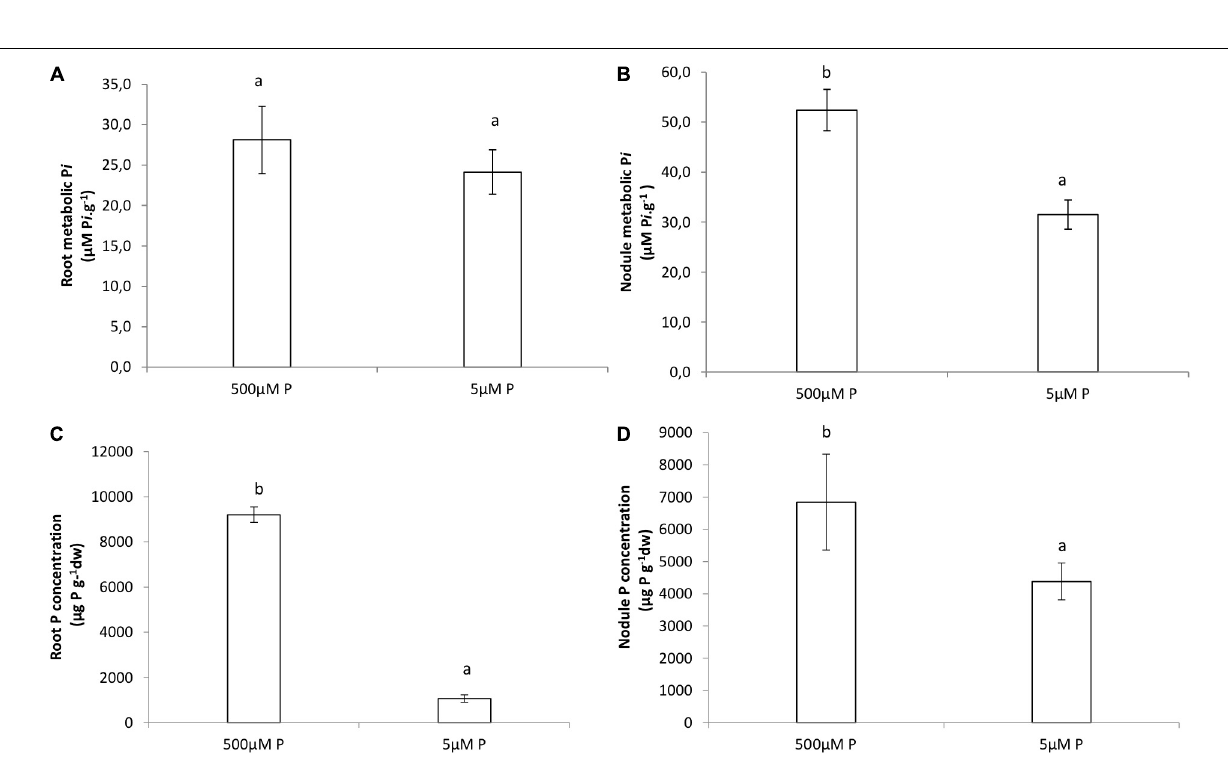
FIGURE 5 | Internal P i ( µ mol P i .g − 1 ) of (A) roots, (B) nodules. Phosphate concentration (mg.kg − 1 ) in (C) roots, (D) nodules of V. divaricata grown under high phosphate (500 µ M P) and low phosphate (5 µ M P) conditions. Values of four replicates are presented as means ± SE. Different letters indicate significant differences between treatments ( P ≤